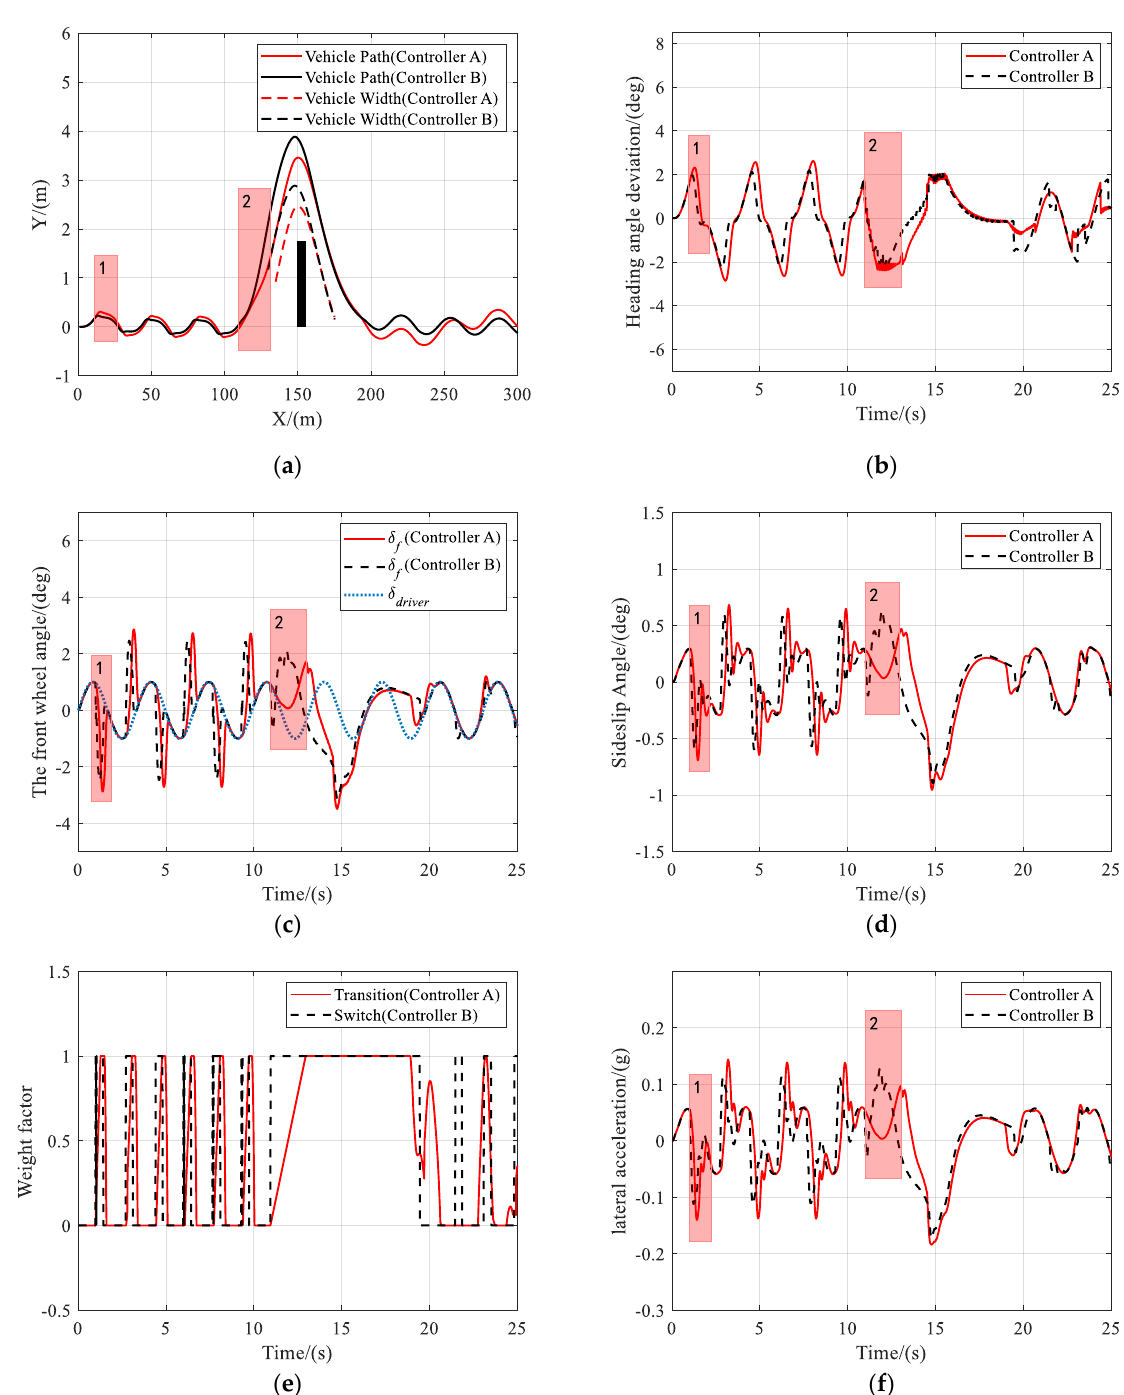
Figure 8. Scenario 2: Simulation results at 36 km/h. ( a ) Vehicle trajectory, ( b ) heading angle deviation, ( c ) the front wheel angle, ( d ) sideslip angle, ( e ) weight factor, and ( f ) lateral acceleration.